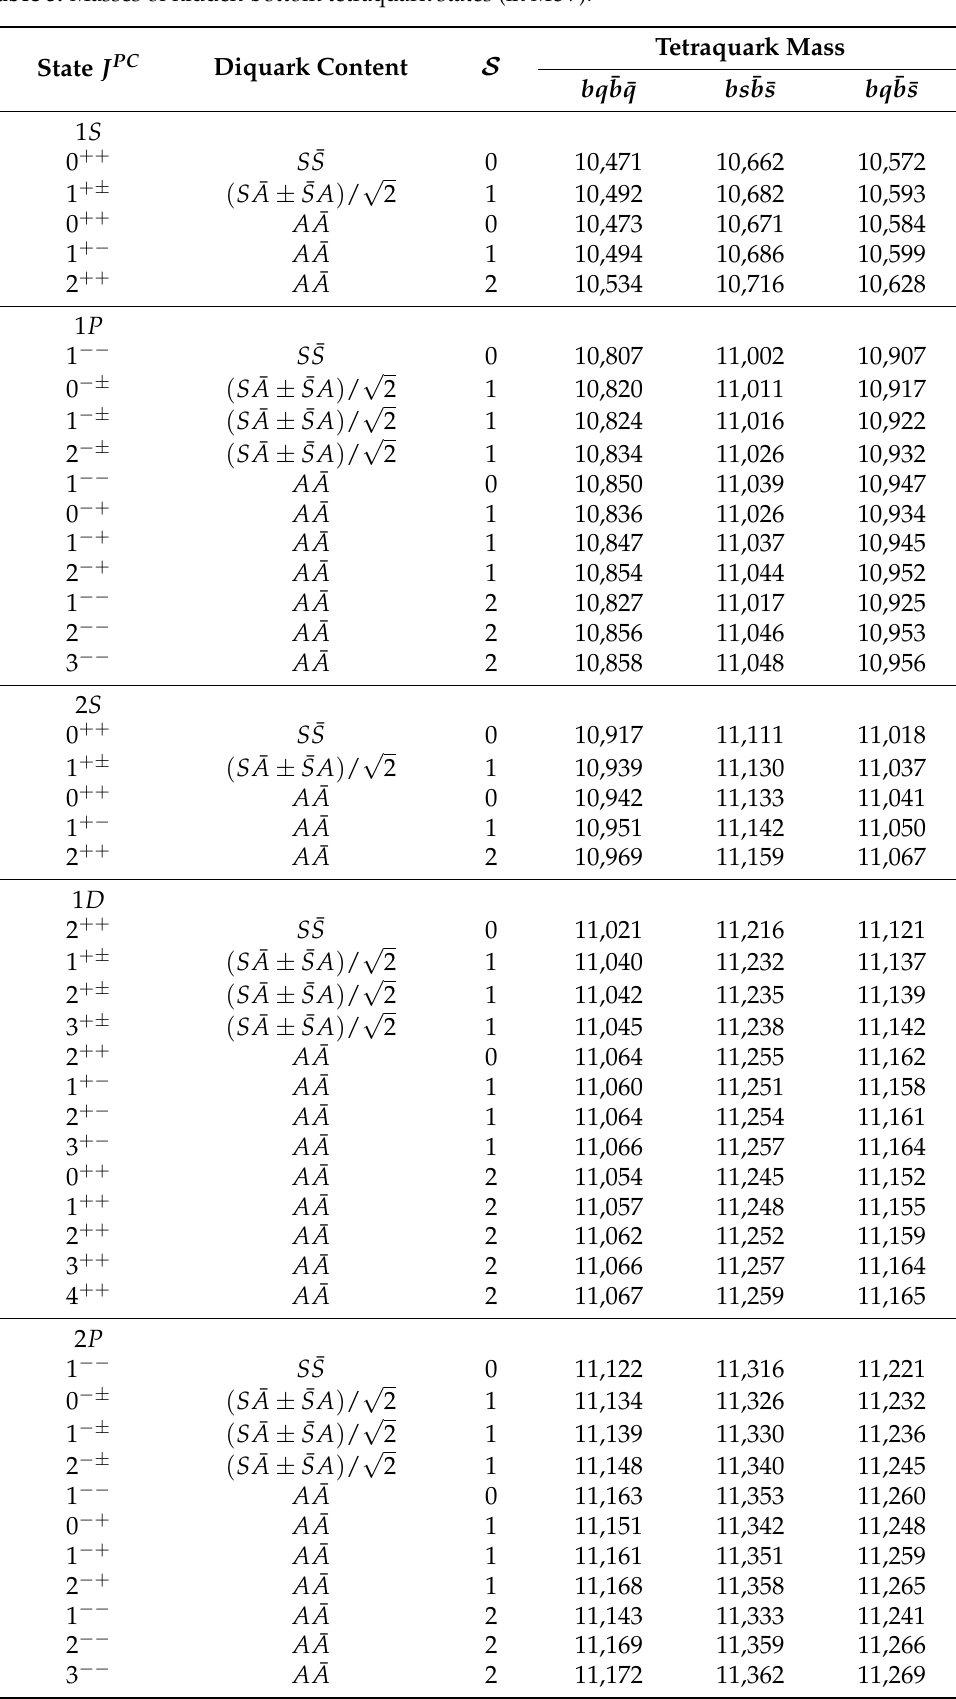
Table 5. Masses of hidden-bottom tetraquark states (in